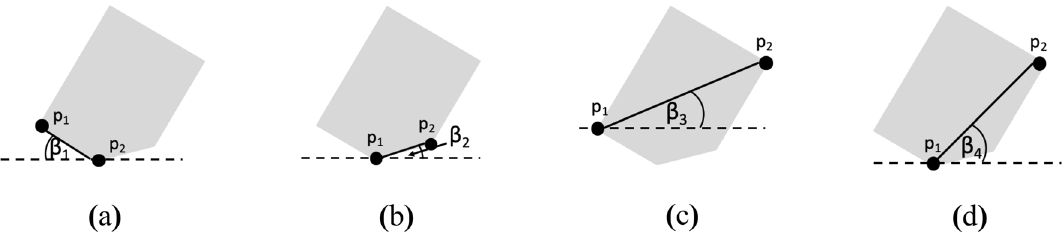
Figure 2. Possible β angles to refer to during alignment using extrema